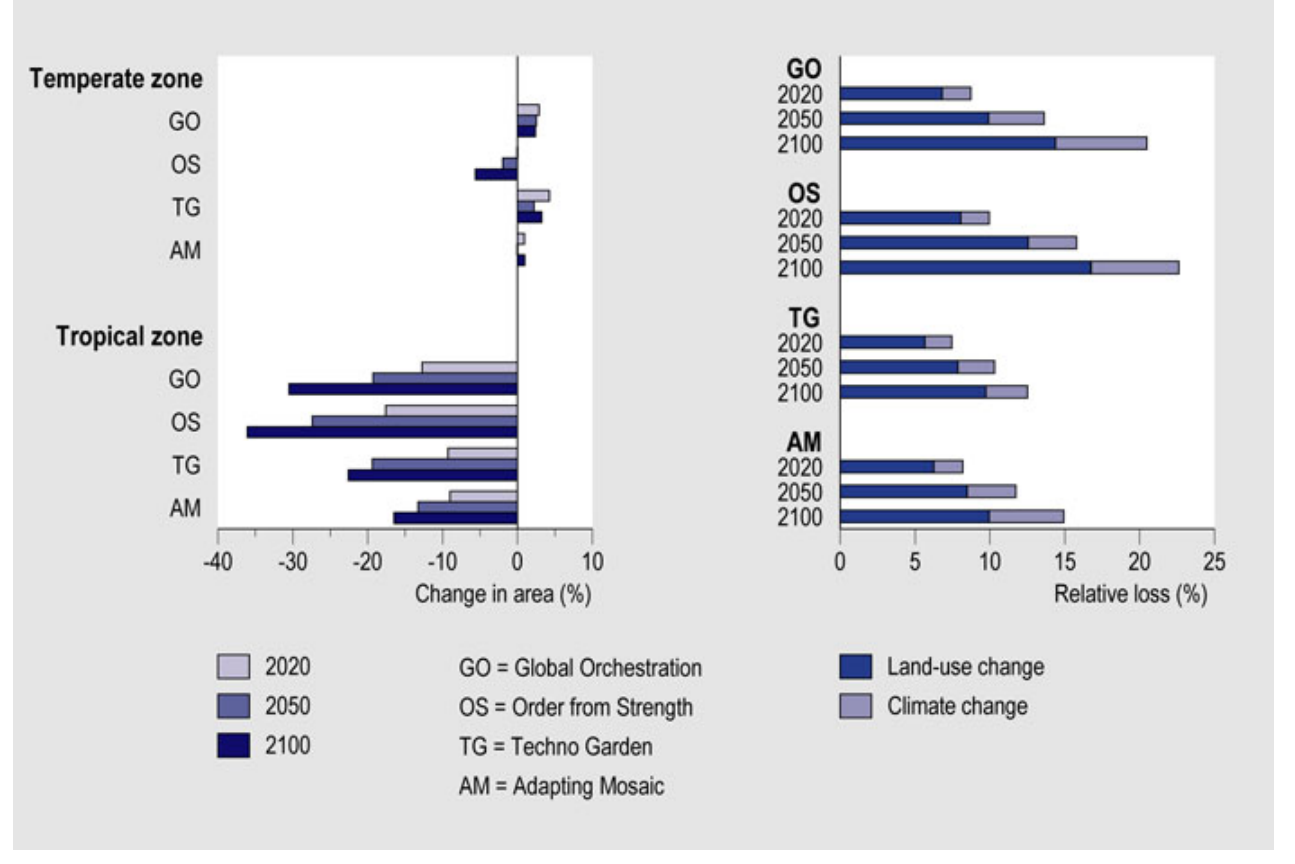
Fig. 3. Changes in the area of natural habitat in the temperate and tropical regions (left) and losses of global vascular plant diversity when populations reach equilibrium with reduced habitat due to conversion to agriculture and climate change (right). Figure is shown for the four Millennium Assessment scenarios. The habitat and biodiversity changes are given relative to the year